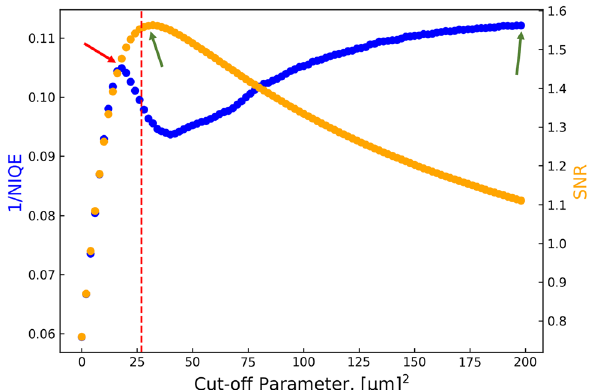
Figure 2. Influence of cut-off parameter, ρ , on the image quality of the wattle flower’s reconstructed phase- object approximation of the effective diffusion coefficient, D True eff, Phase ( r ; �) . Image quality is measured by the (blue) reciprocal of the Naturalness Image Quality Evaluator (NIQE) 69 and (orange) signal-to-noise ratio (SNR). The dashed red vertical line denotes the optimal cut-off parameter that appropriately considers both metrics and the verdict of four human